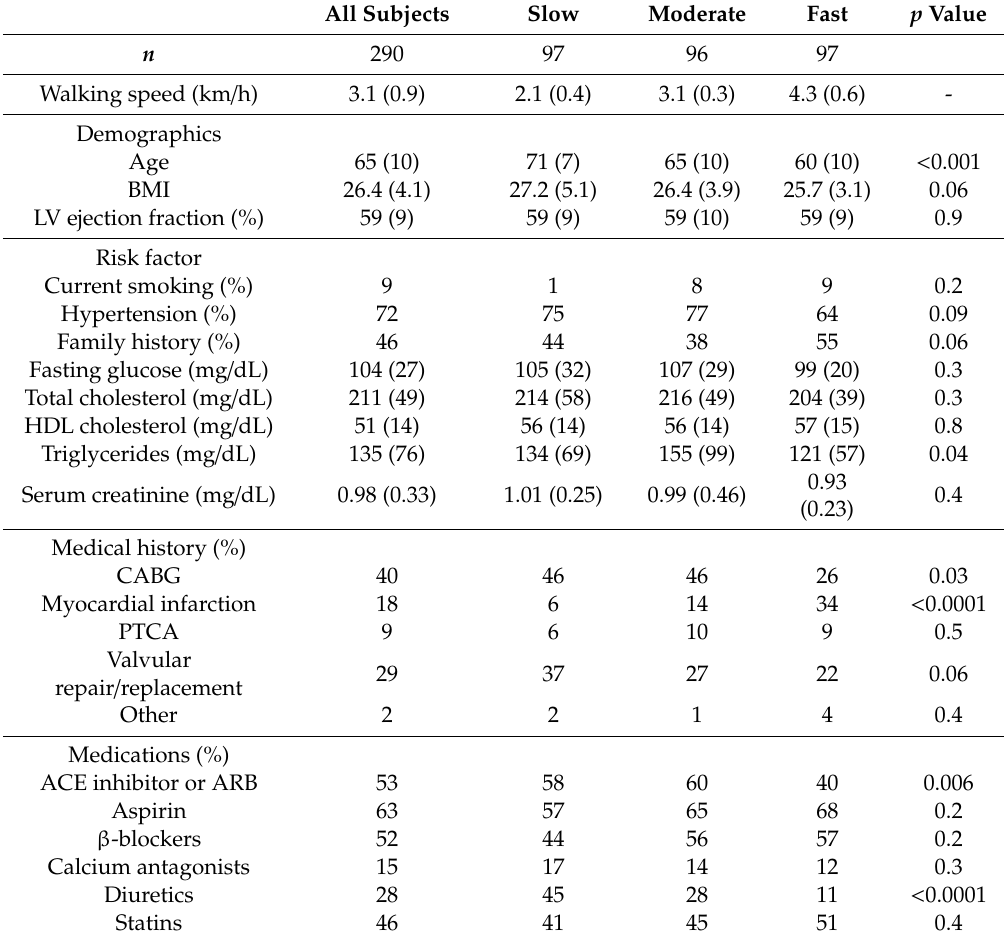
Table 1. Demographic and clinical characteristics of the 290 subjects by baseline tertiles of walking